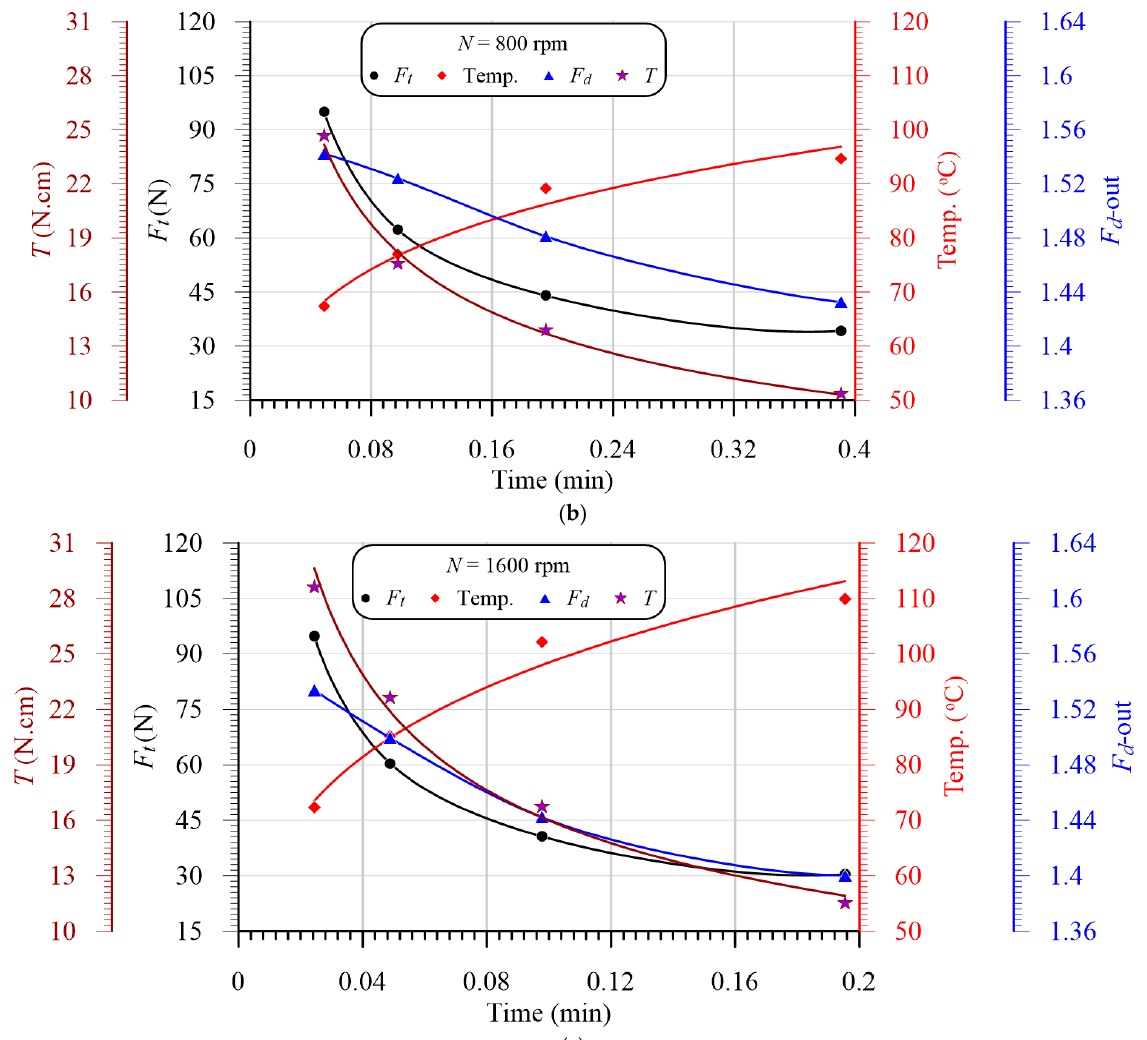
Figure 15. Variation in thrust force, delamination, and temperature vs. the cutting time at different speeds. ( a ) N = 400 rpm; ( b ) N = 800 rpm; ( c ) N = 1600 rpm.